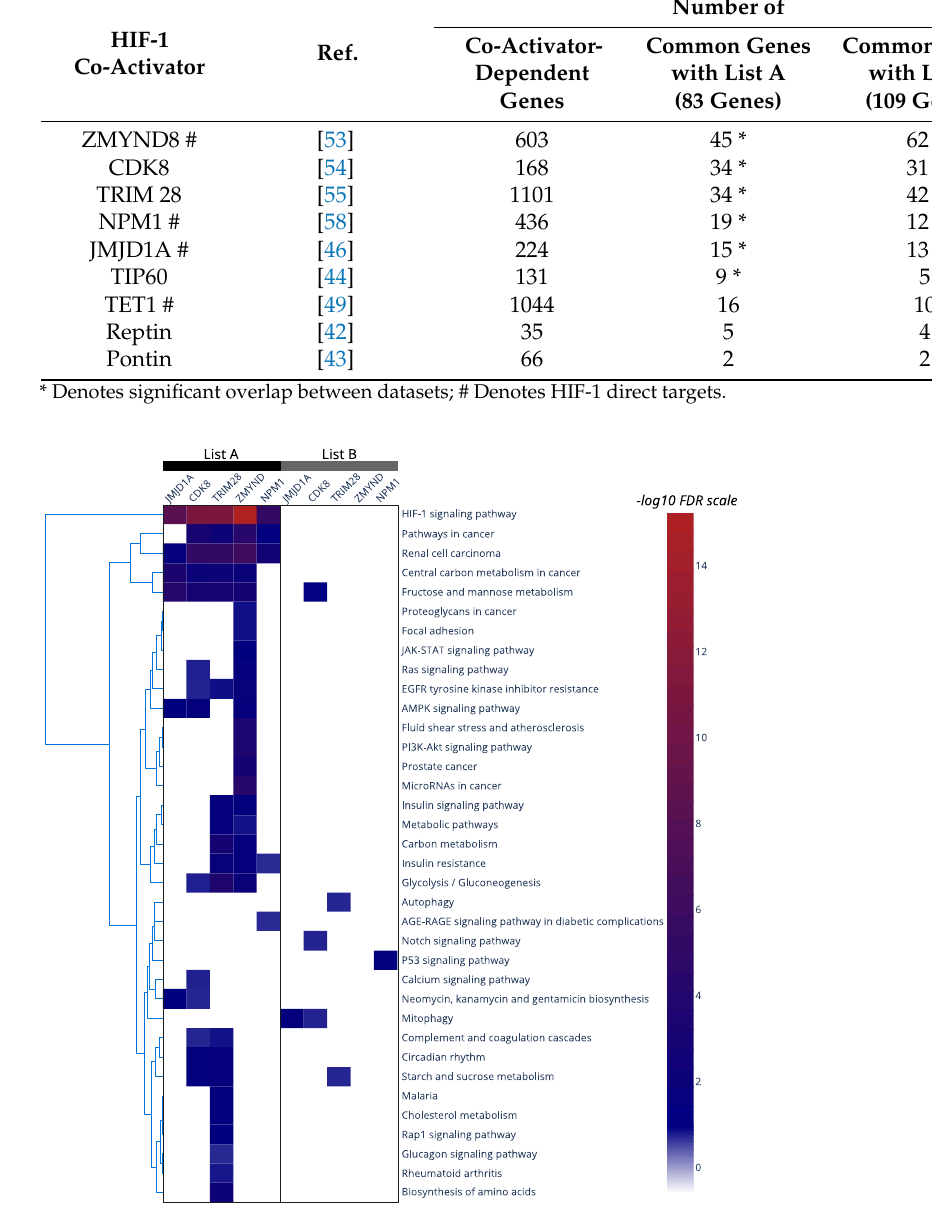
Figure 2. Heatmap of KEGG pathway analysis of common genes between JMJD1A, CDK8, TRIM28, ZMYND8 or NPM1 (as indicated) and LIST A ( left panel) or LIST B ( right panel). The -log10 FDR values for the various pathways were plotted for each of the overlapping gene sets. An FDR cut ‐ off of 0.05 was used for statistical significance. Clustering was performed using the Nearest Point algo ‐ rithm with Euclidean distance from SciPy [117]. The heatmaps were plotted using the python Plotly package (Plotly Technologies Inc. Collaborative data science, Montréal, QC, Canada, 2015. https://plot.ly accessed on 31 January 2023).